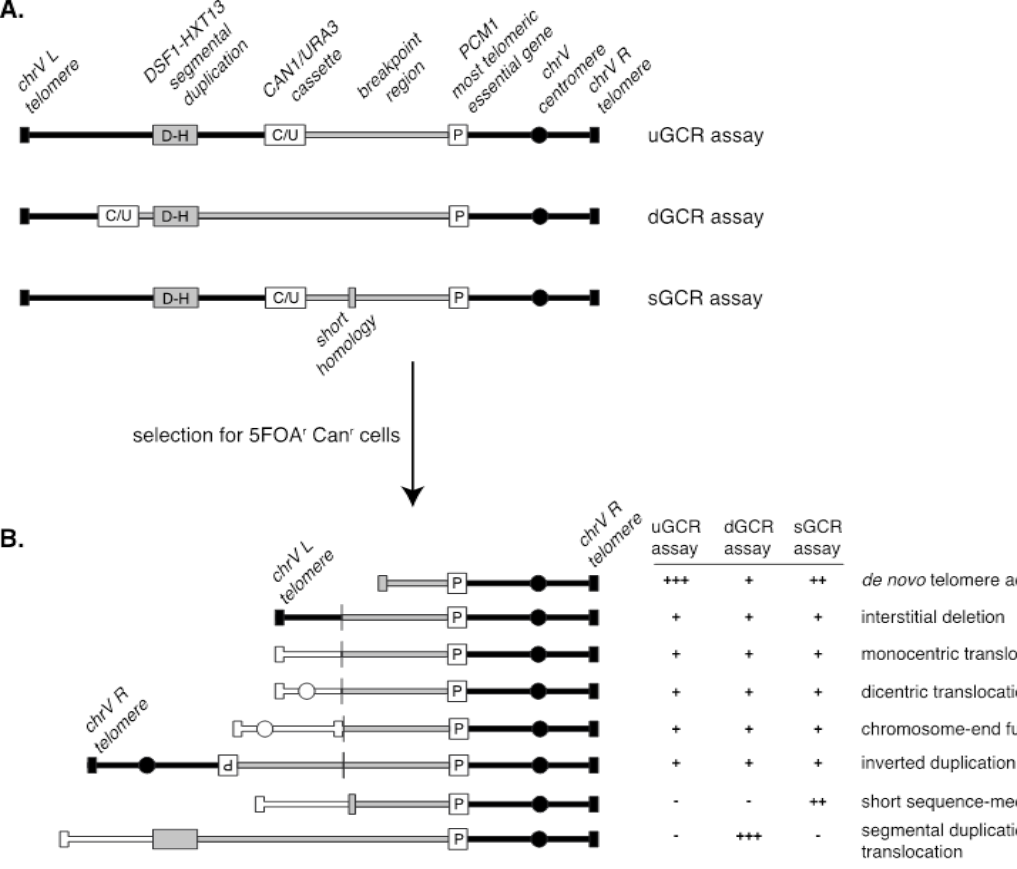
FIGURE 5. Assays to study gross chromosomal rearrangements. (A) Diagram of the uGCR, dGCR, and sGCR assays depicting the position of the CAN1/URA3 counter- selectable cassette (white box labeled “C/U”) relative to the DSF1-HXT13 segmental duplication (grey box labeled “D - H”), and the most telomeric essential gene PCM1 (white box labeled “P”). The grey region of the chromosome corresponds to the breakpoint region, which lies between PCM1 and the CAN1/URA3 cassette and is the region where one of the breaks associated with the GCR must occur. The grey box in the sGCR assay corresponds to a region of short homology containing a repetitive tRNA and ~100 bp of a repetitive delta sequence. (B) Selection of GCR assay-containing strains for resistance to 5-fluoroorotic acid (5-FOA) and canavanine (Can) selects for strains in which one of a number of GCRs has formed; these types of GCRs are selected at different rates in the different GCR assays. White chromosomes indicate translocations to other chromosomes (or alternatively different regions of the assay chromo- OPEN ACCESS | www.microbialcell.com